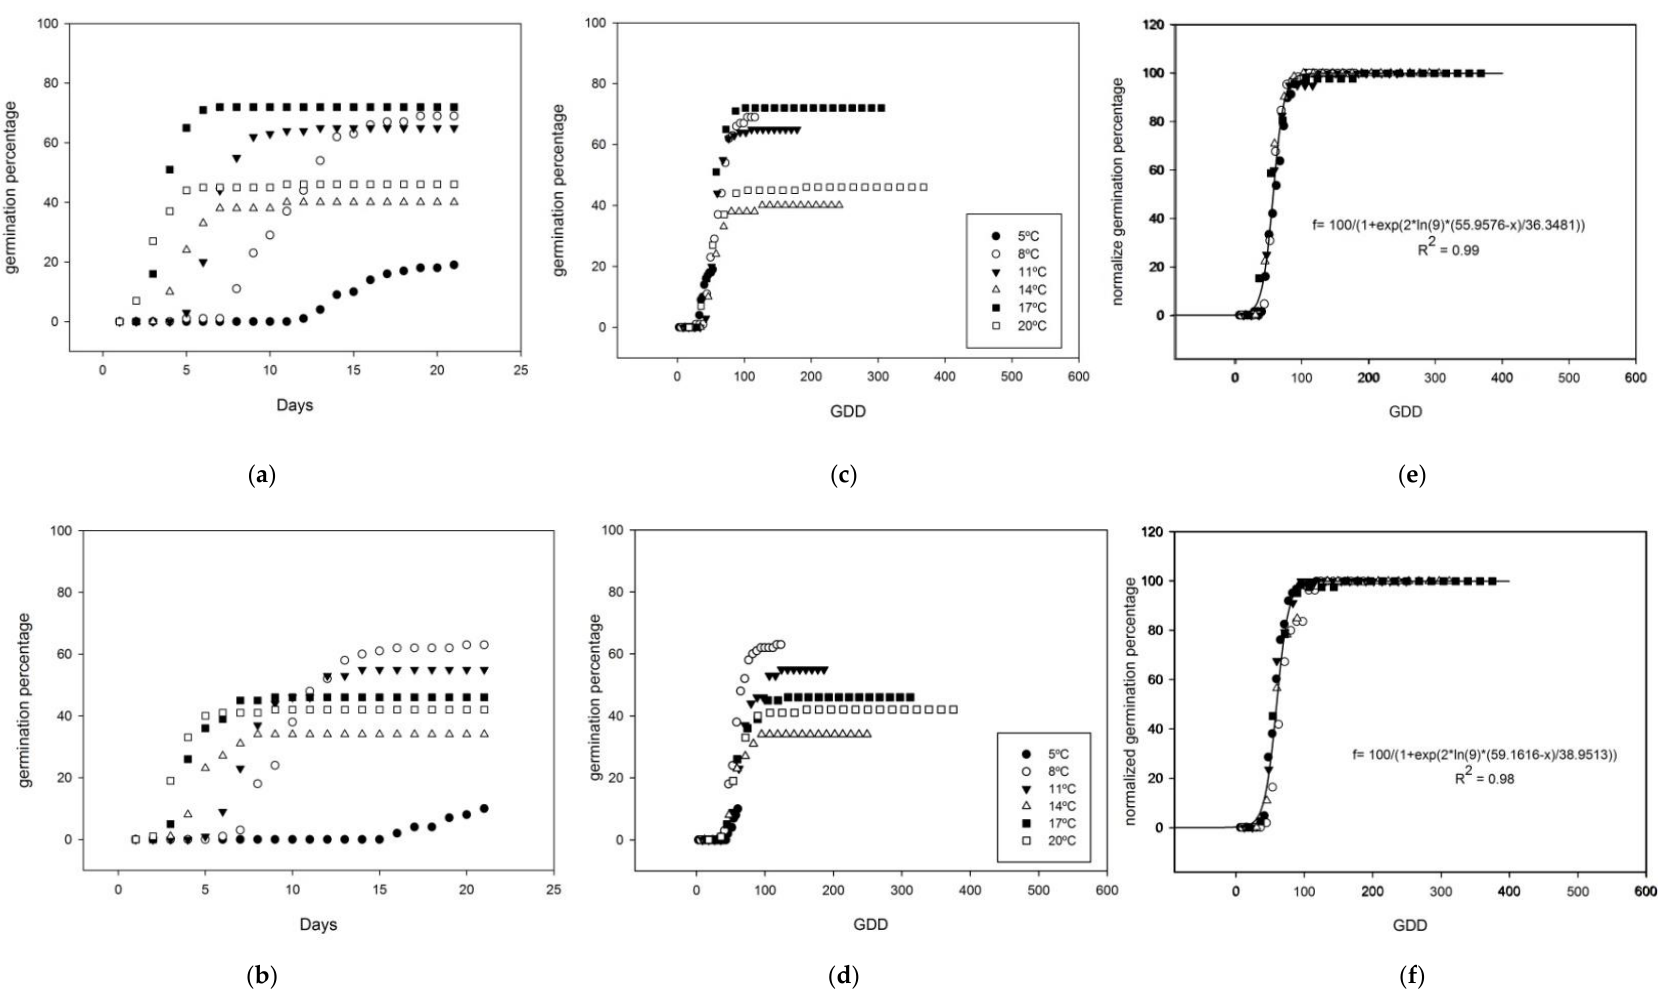
Figure 3. Cumulative germination seeds of Thlaspi arvense from Morris produced at Morris. ( a ), apical, and ( b ), basal, seed germination percentages are shown against days after sowing; ( c ), apical, and ( d ), basal seed germination percentages shown against growing degree days (Tb = 2.13 °C and 2.49 °C, respectively, for basal and apical seeds); ( e ), apical, and ( f ), basal seed germination percentages shown as normalized values to 100%. In ( e ) and ( f ), the Boltzmann formula for the germination model is provided for both apical and basal seeds, with the corresponding R 2 .